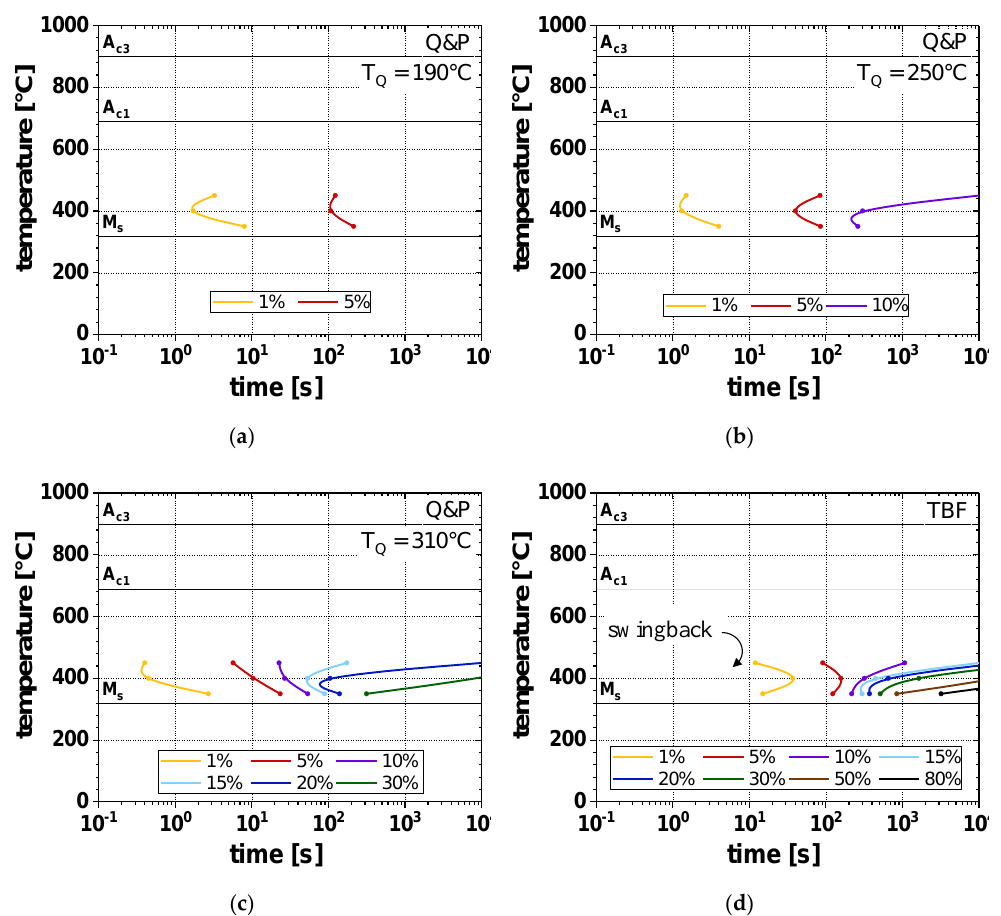
Figure 11. Time-temperature-transformation (TTT) diagrams for ( a – c ) Q&P steels ( T Q = 190, 250, and 310 °C) and ( d ) TBF steels.